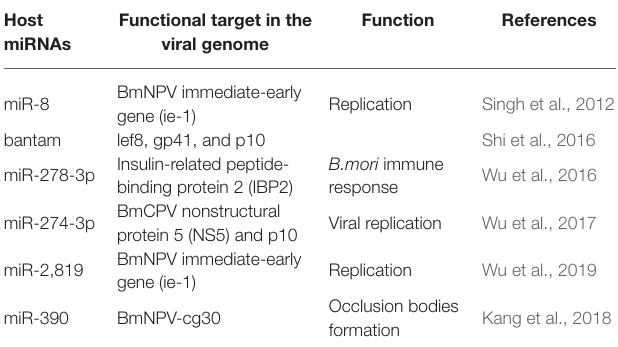
TABLE 1 | Host miRNAs targeting viral